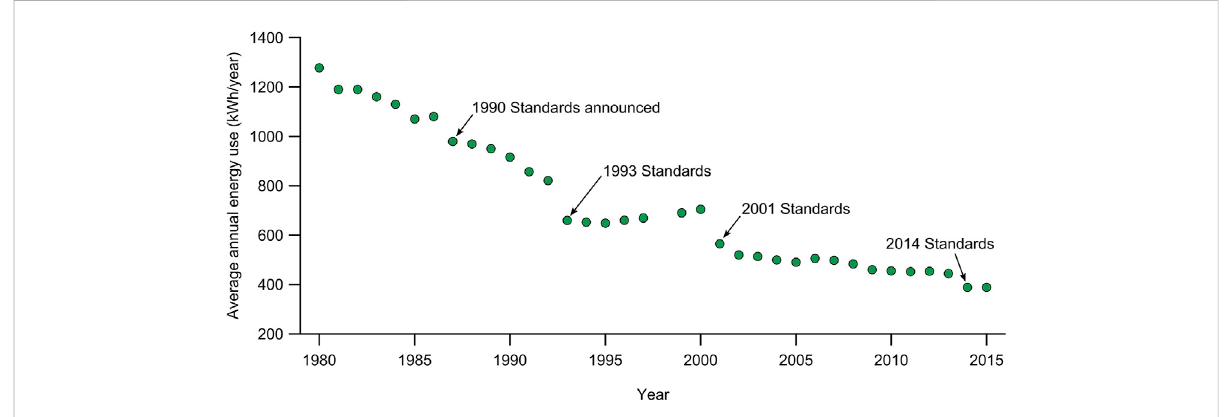
FIGURE 6 Average annual electricity use of new refrigerator-freezers and freezers. Data sources: (Rosenfeld, 1999; Energy Conservation Standards for Residential Refrigerators, Refrigerator-Freezers, and Freezers, 2010; AHAM, 2018).